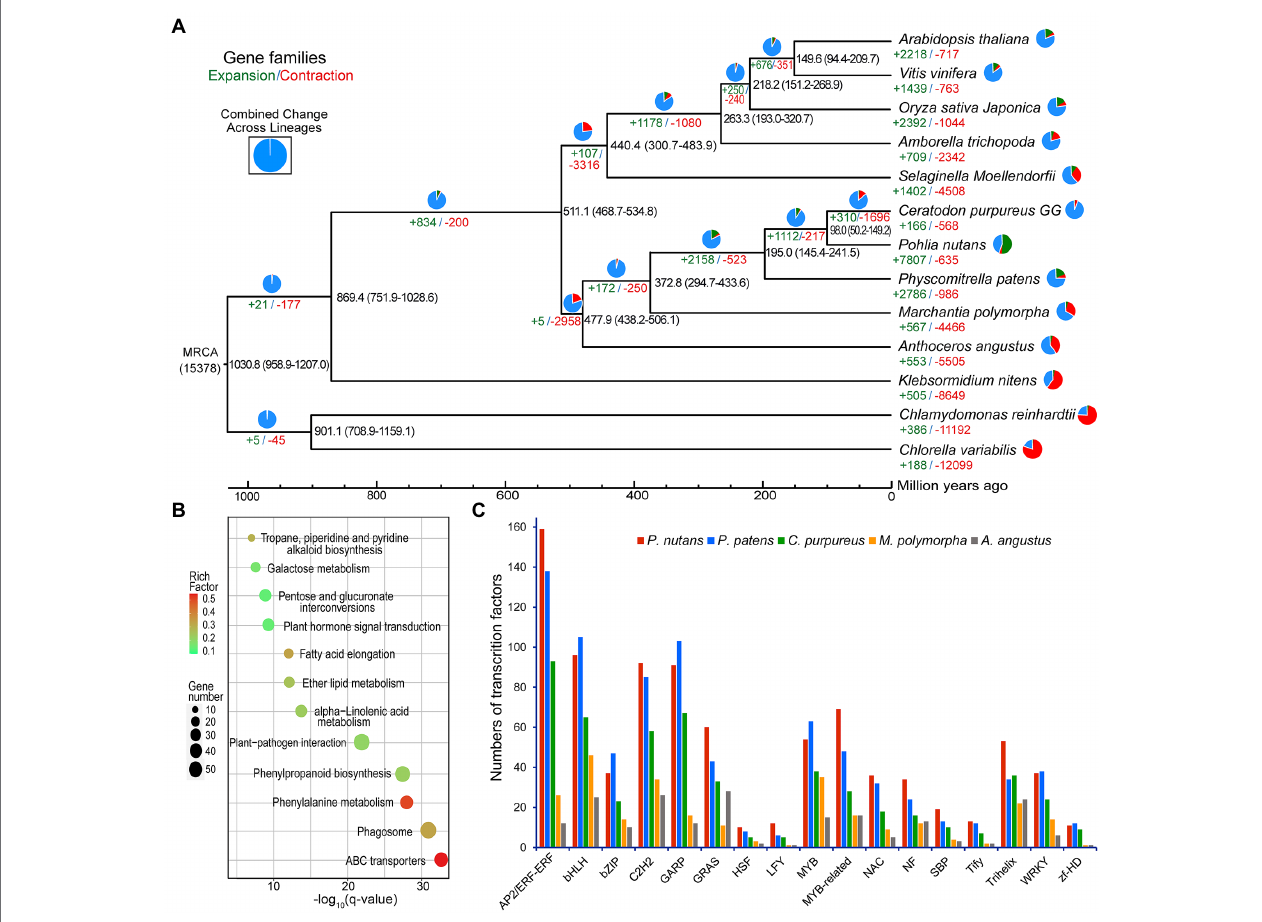
FIGURE 3 | Evolutionary analysis and gene-family expansion and contraction among several green plants. (A) The number of significantly expanded and contracted gene families was shown on a time-calibrated phylogenetic tree. The numbers of expanded (green) and contracted (red) gene families were identified by CAFE software and shown above the branches. The estimated age of speciation was indicated on the branches with blue numbers (million years ago, Ma). (B) Scatterplot of KEGG enrichment of the expanded gene families in Pohlia nutans . (C) Numbers of selected stress-related transcription factor genes in five bryophyte